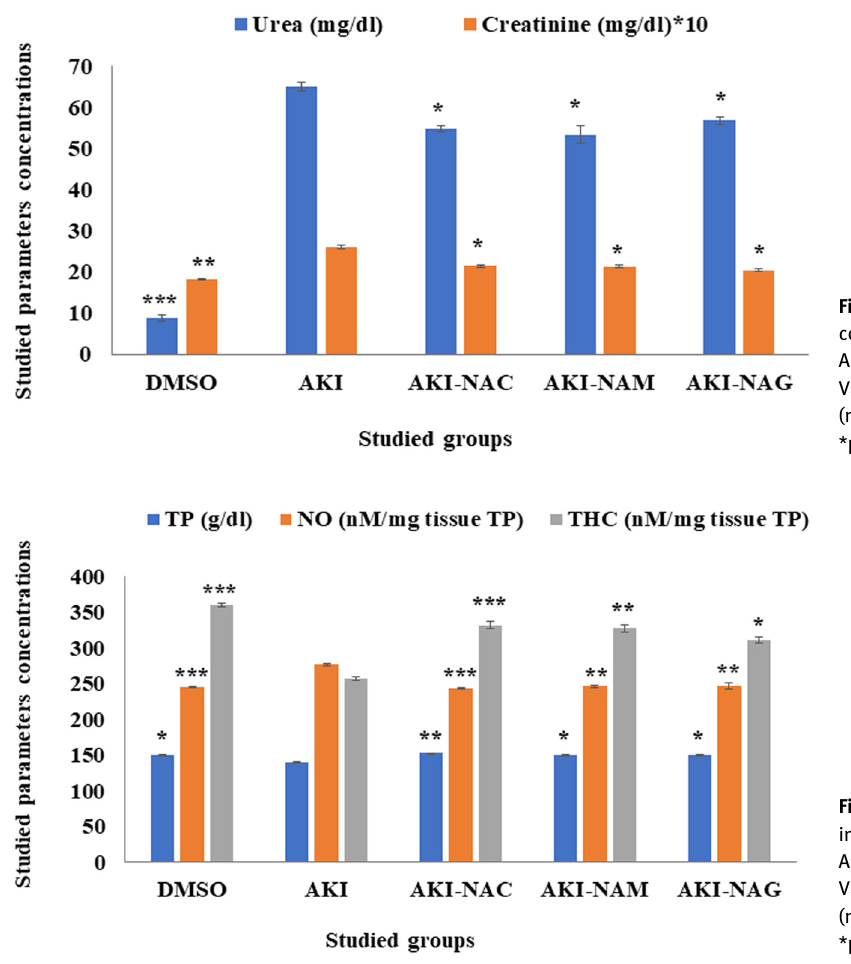
Figure 2: TP and NO concentrations and THC in renal tissue of DMSO, AKI, AKI-NAC, AKI-NAM and AKI-NAG groups. Values were expressed as mean ± SE (n=10).Signi fi cance:***p<0.001, **p<0.01, *p<0.05 comparing to